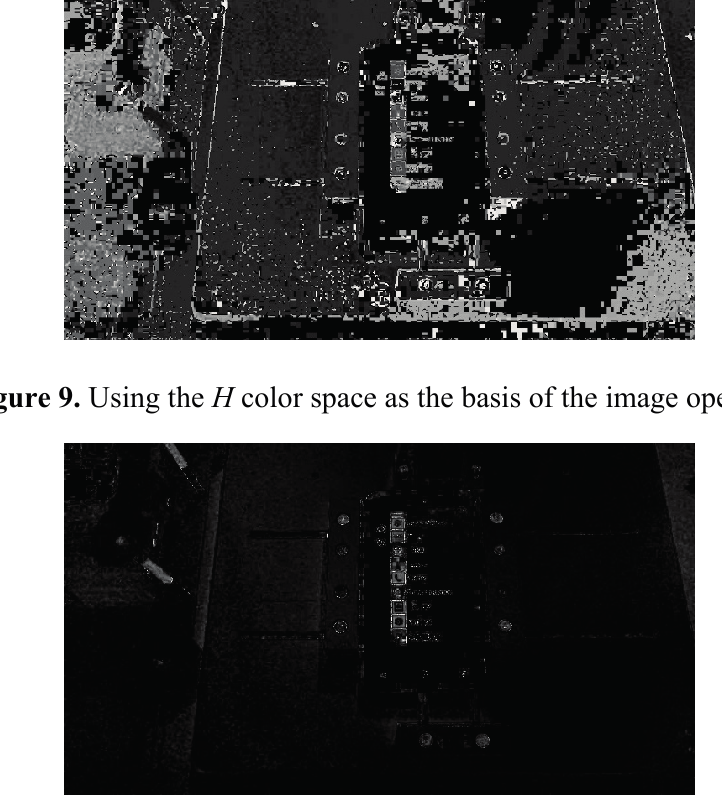
Figure 10. Using the S color space as the basis of the image